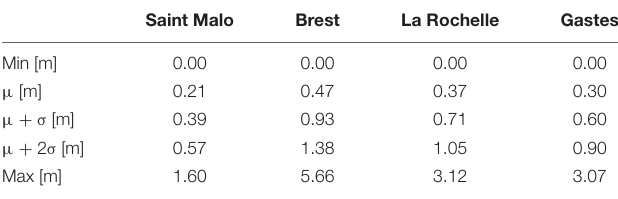
TABLE 4 | Maximum water height associated with the design database; µ , σ and Max correspond to the mean, standard-deviation and maximum modeled